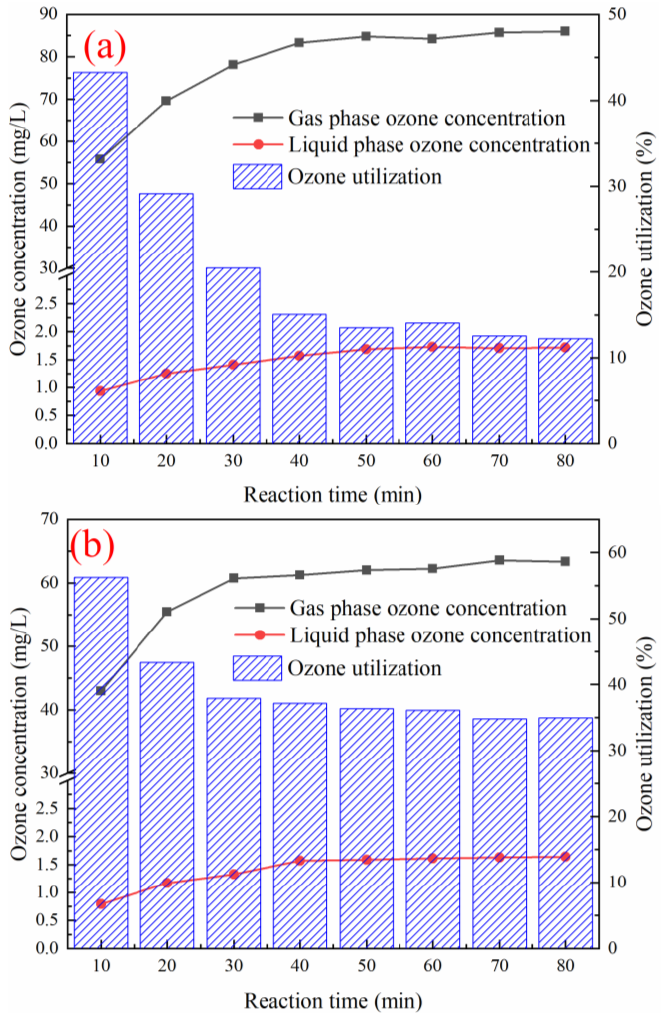
Figure 7. Ozone utilization under different reaction conditions: ( a ) ozone alone; ( b ) O 3 +Mn/Zn@PG.